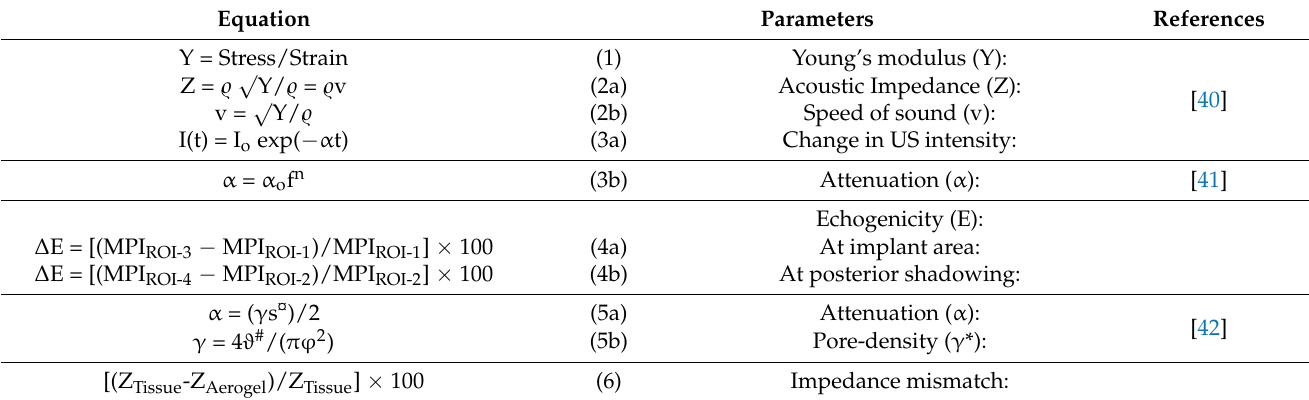
Table 2. Table summarizing equations used in this